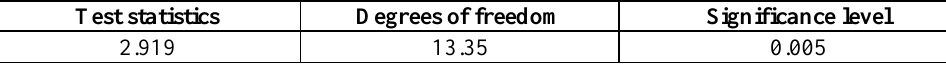
Table 7. F-Limer test to determine panel or pooling method